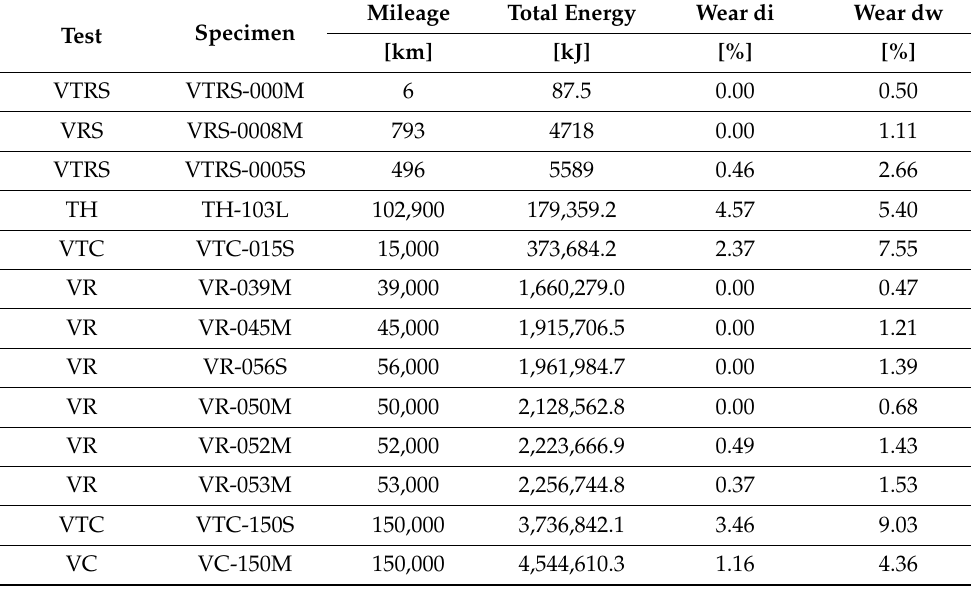
Table A1. Relative wear values of facings from the different automotive